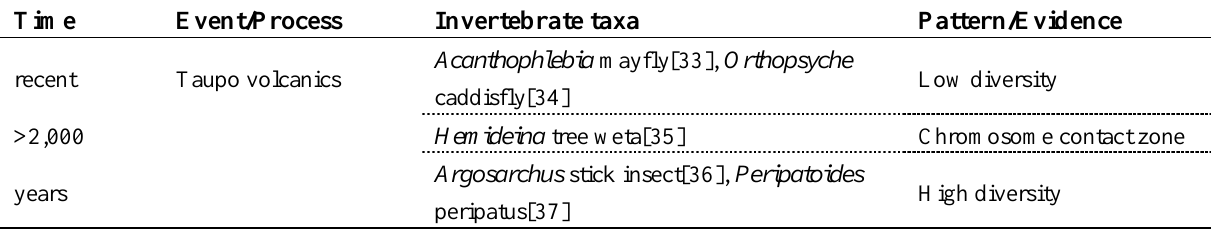
Table 2. Summary of New Zealand invertebrate phylogeography/phylogenetic biogeography within genera, highlighting inferred geophysical process that have left signatures in the distribution and depth of genetic diversity. -Last glacial maximum (LGM) ending 20 k years